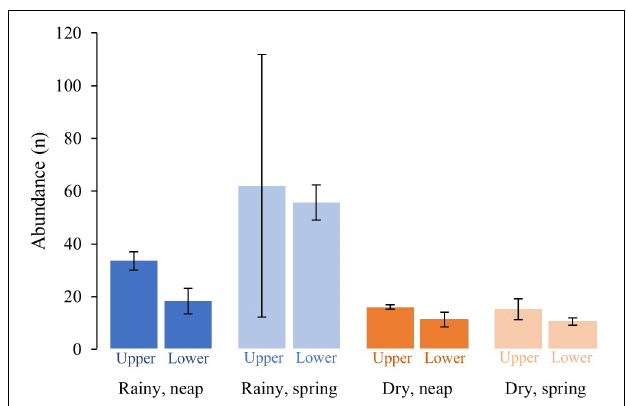
FIGURE 3 | Average abundance of fish caught per day according to the season, tide, and zone. Error bars: ± SE.